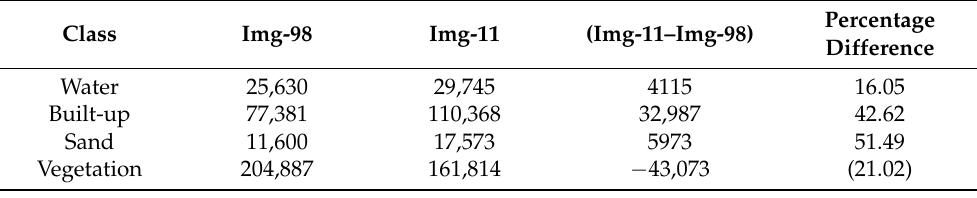
Table 7. Change computation table based on machine-learning-based models accuracy.